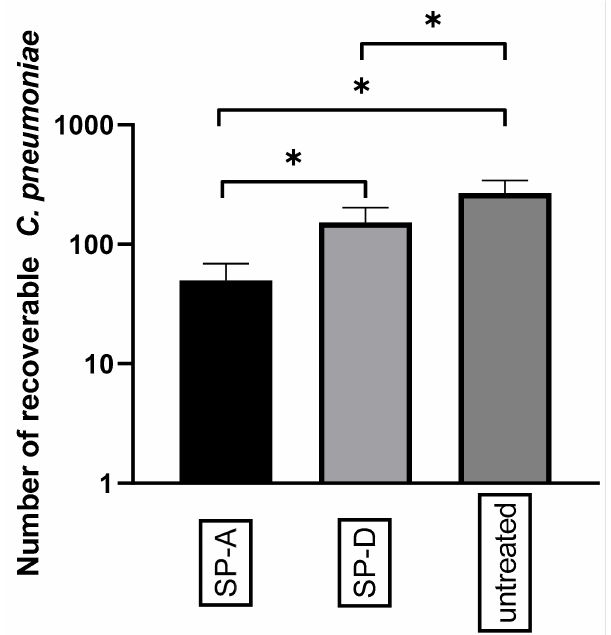
Figure 4. Anti-chlamydial effect of SP-A and SP-D. C. pneumoniae EBs were treated with either SP-A, SP-D, or left untreated. After 1 h of incubation, the samples were inoculated into McCoy cells and fixed 48 h post-infection. The number of C. pneumoniae inclusions was determined via indirect immunofluorescence staining. Each bar denotes the mean number of inclusions in three parallel cultures ± standard deviation (* p <